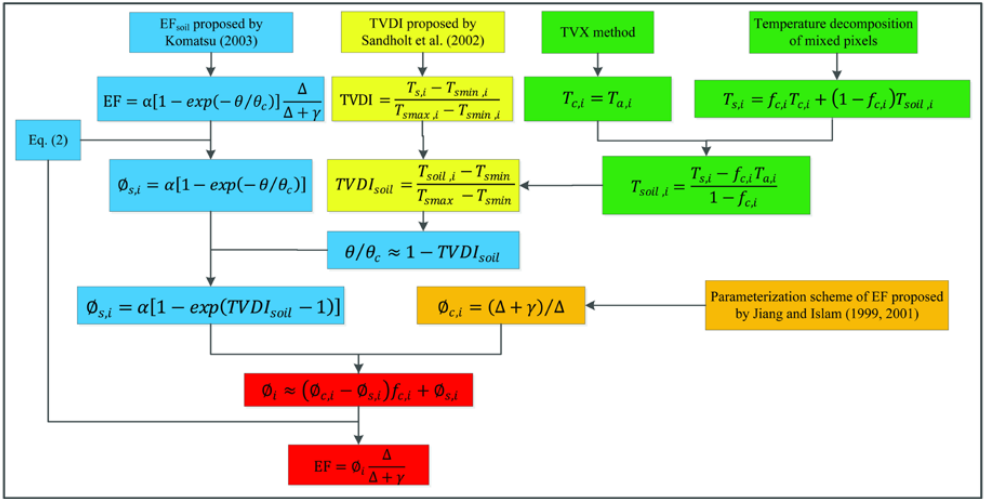
Figure 3. Flowchart of the proposed new parameterization scheme of EF.